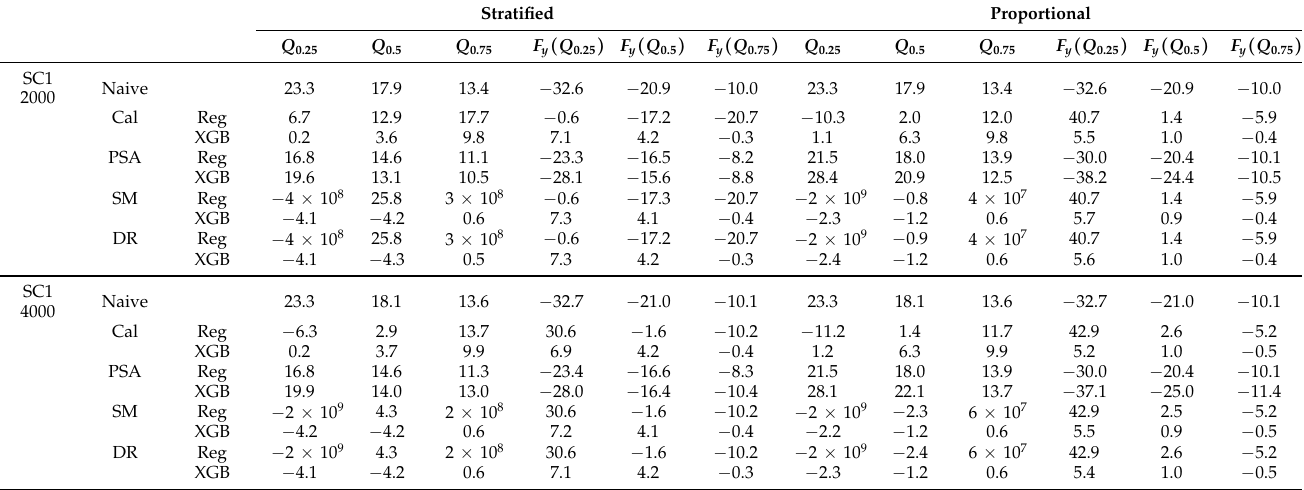
Table 1. Bias (%) for each reference probability sample, parameter, non-probability sampling and size, method and machine learning model (linear/logistic regression or